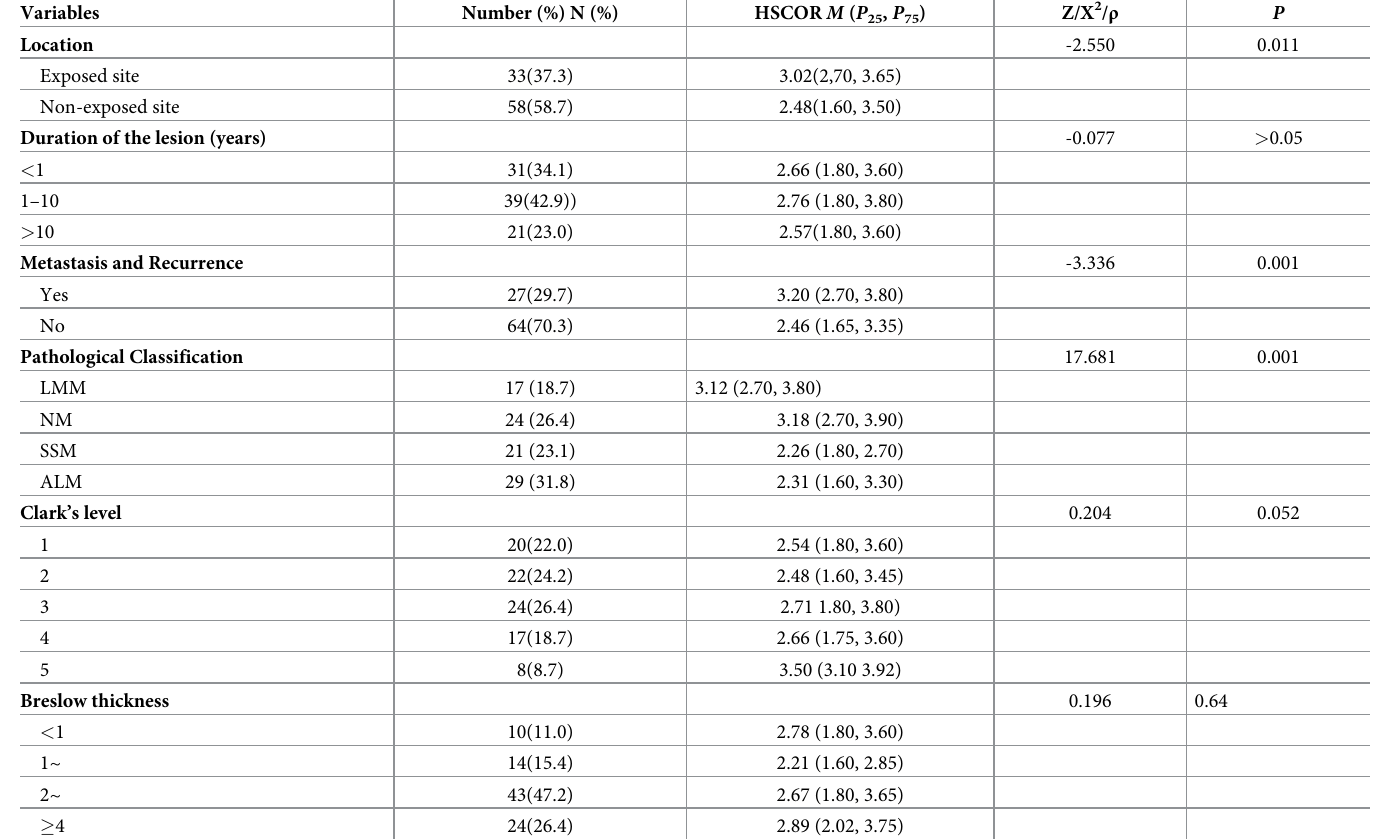
Table 2. HSP105 expression in different clinicopathological features of